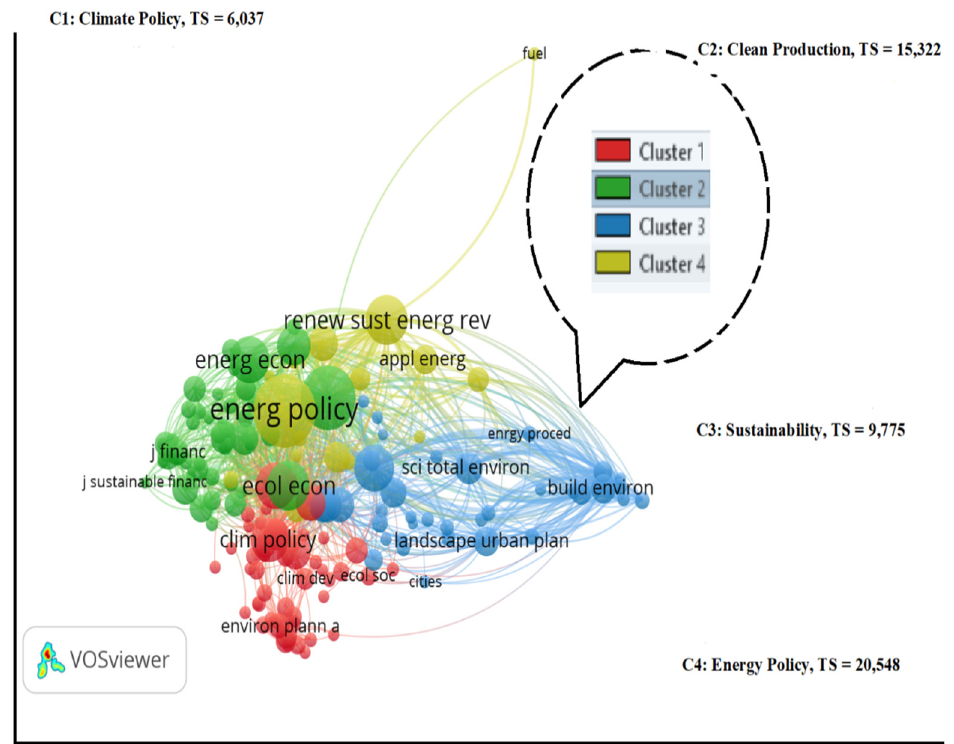
Figure 5. Co-citation analysis. Source: Authors’ own compilation using VOSviewer.